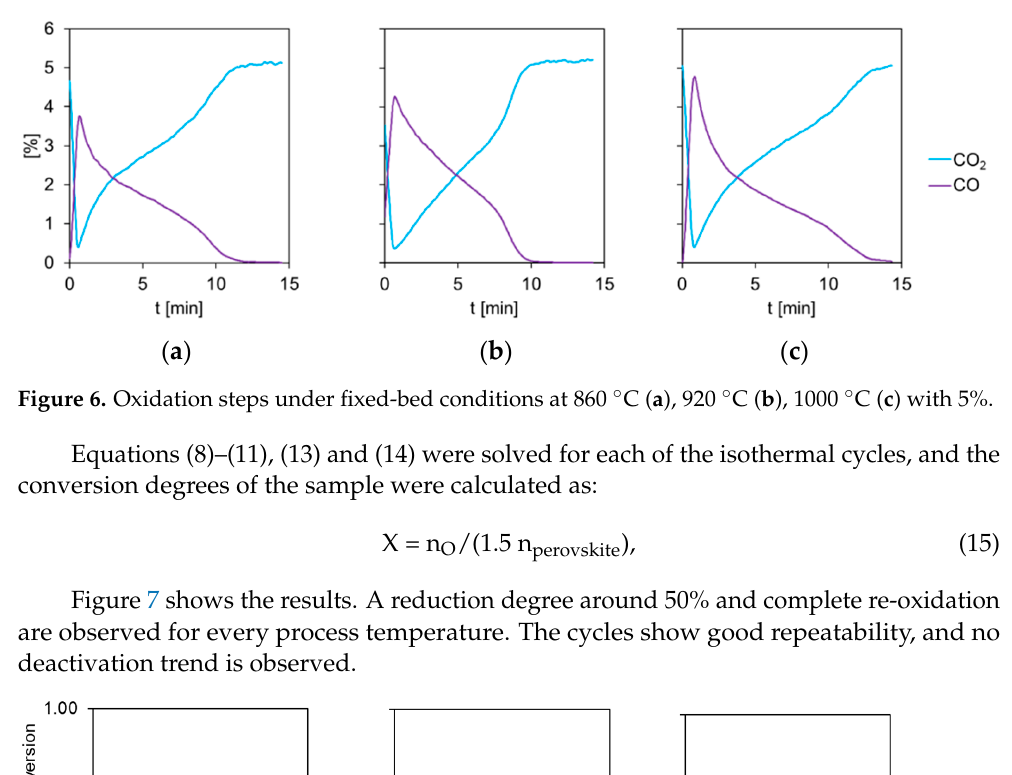
Figure 5. Reduction steps under fixed-bed conditions at 860 °C ( a ), 920 °C ( b ), 1000 °C, ( c ) with 5%.